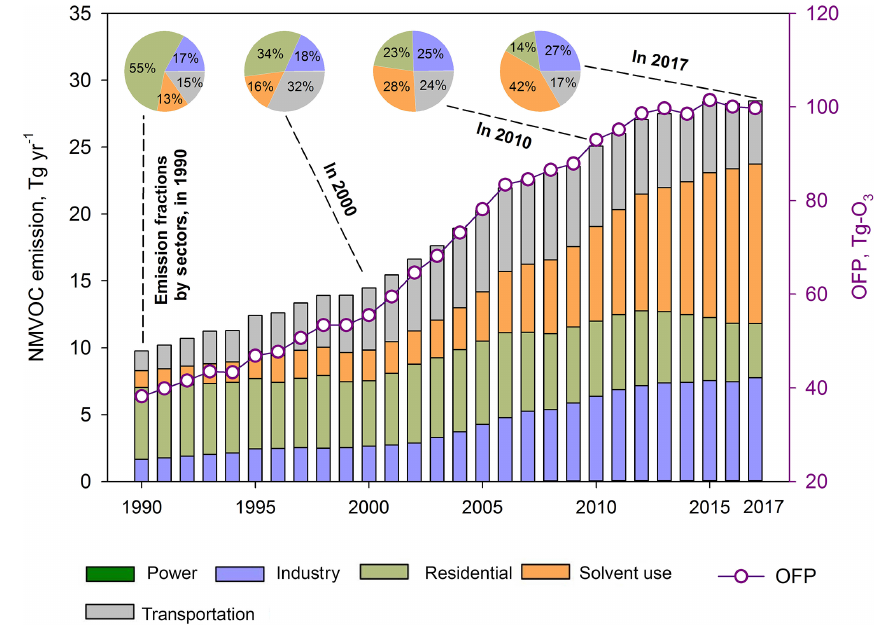
Figure 1. NMVOC emissions in China for the period from 1990 to 2017.